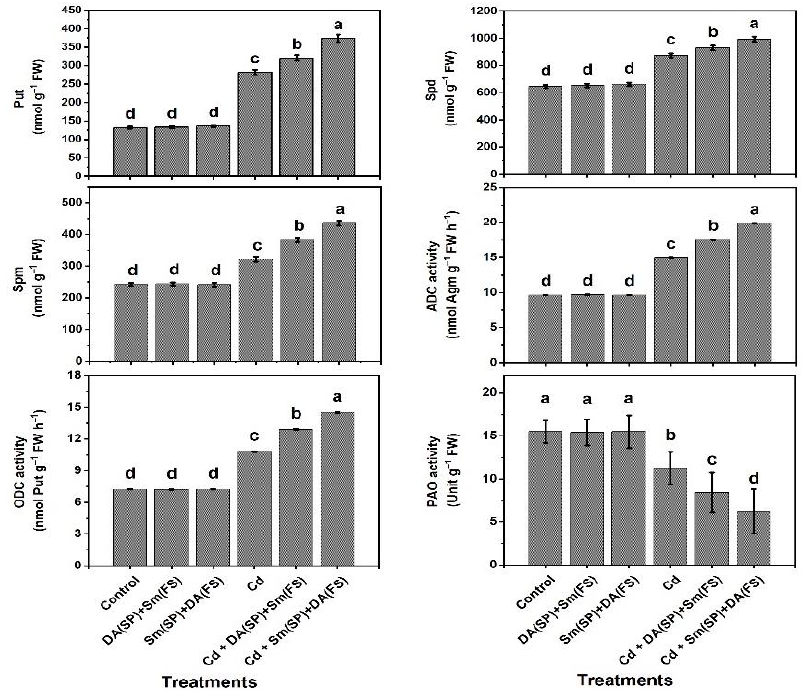
Figure 8. Effects of seed priming (SP) and foliar spraying (FS) with silymarin (Sm) or dopamine (DA) on polyamine content (Put, Spd, and Spm) and activities of polyamine metabolic enzymes (ADC, ODC, and PAO) of cadmium-stressed Phaseolus vulgaris plants. Columns labeled with same or different letters within each plot signify non-significant or significant differences, respectively, based on LSD test ( p ≤ 0.05). Bars represent SE values (three replicates). Put = putrescine, Spd = Spermidine, Spm = Spermine, ADC = Arginine decarboxylase, ODC = Ornithine decarboxylase, and PAO = Polyamine oxidase.